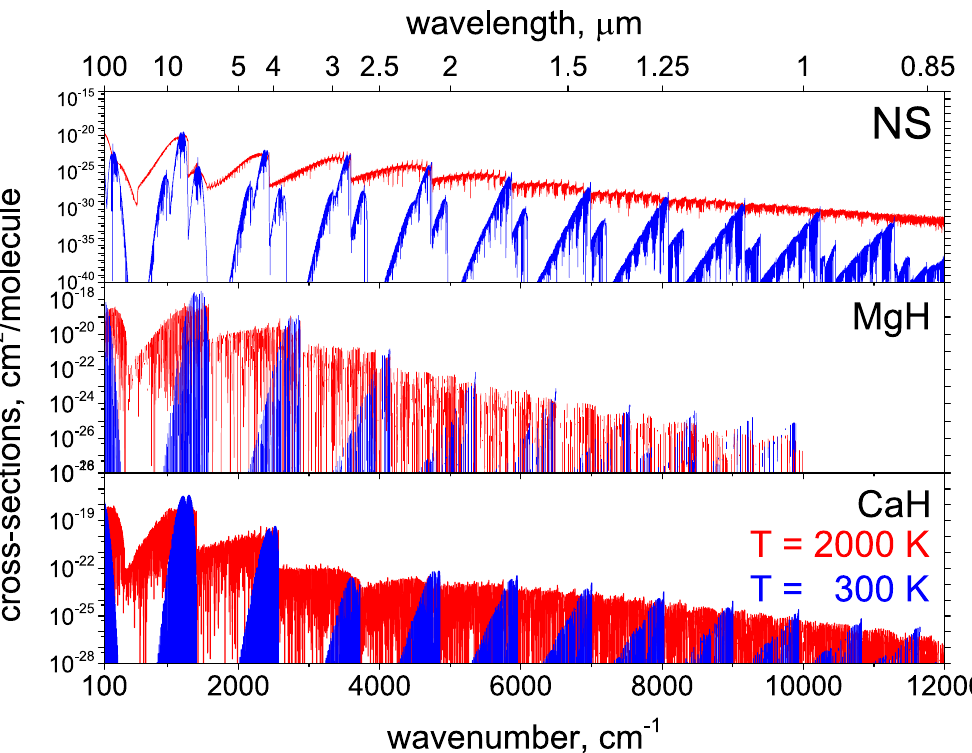
Figure 6. Cross sections for alkaline earth monohydrides MgH and CaH from the Yadin ExoMol line lists [51] and NS from the SNaSH line list